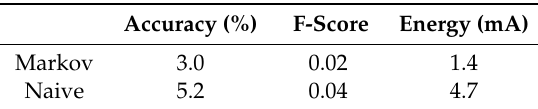
Table 3. The average prediction error of random assignments, made on energy consumption, F-score and accuracy for the naive and Markov chain